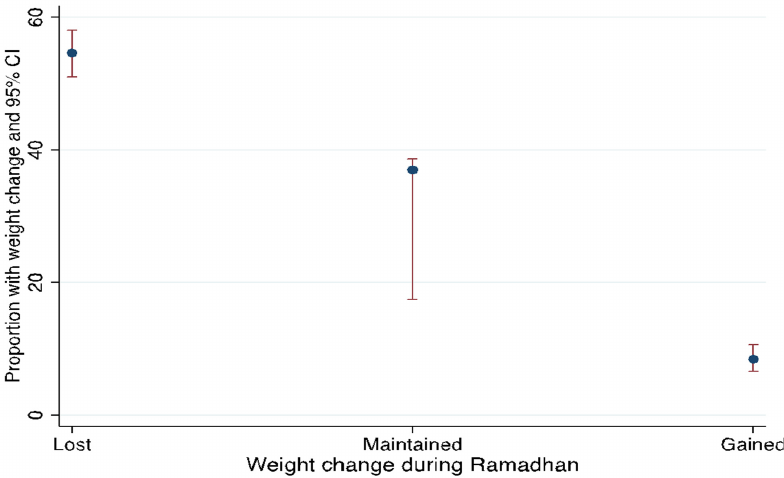
Figure 2. Respondent’s weight change during Ramadan.